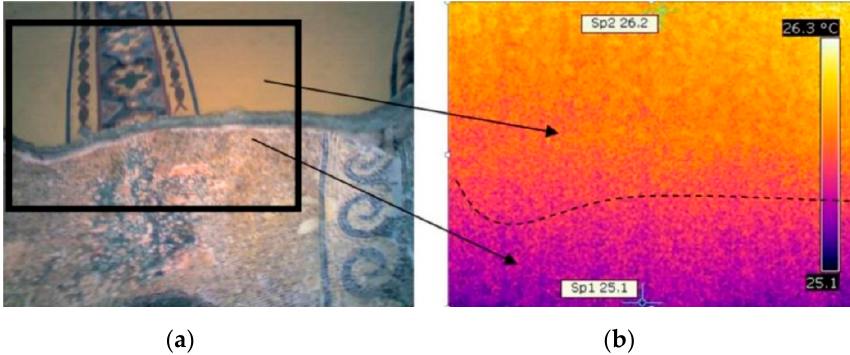
Figure 3. Infrared thermography (IRT) results at the plaster (top)–mosaic (underneath) interface in Hagia Sophia (Istanbul, Turkey): ( a ) visible image and the examined area; ( b ) thermogram showing the temperature difference of a mean value of 1.1 °C between the plastered surface and the mosaic. After Moropolou et al. [62] (reprinted with copyright permission).